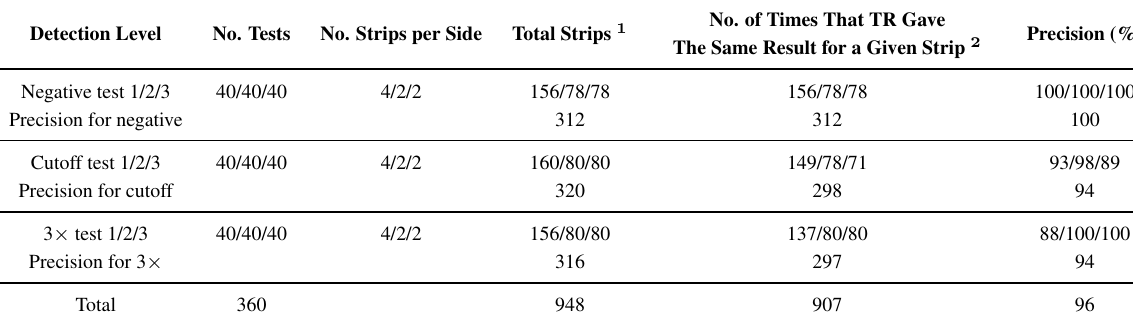
Table 7. Precision test